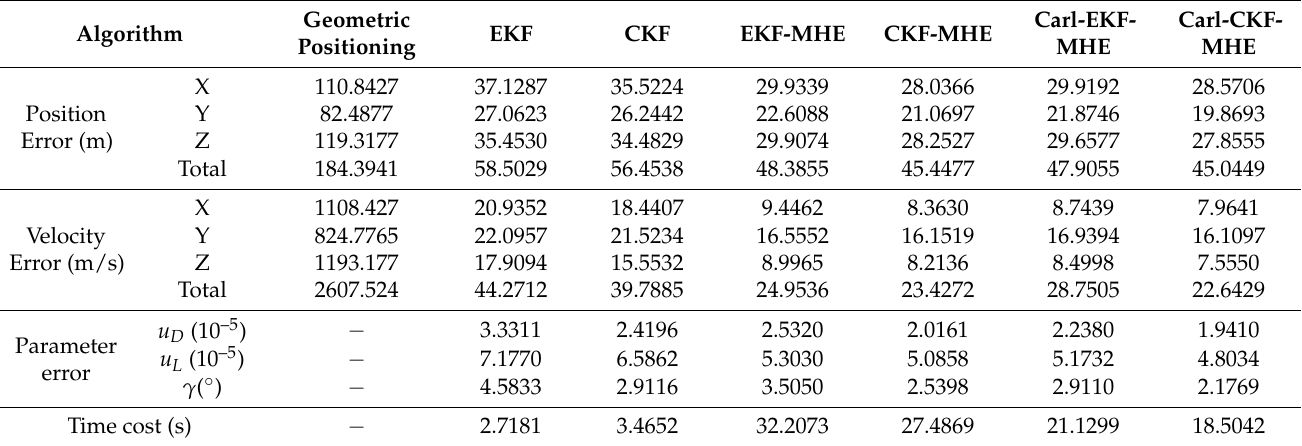
Figure 12. Bank angle estimation errors. Table 2. Joint state and parameter estimation